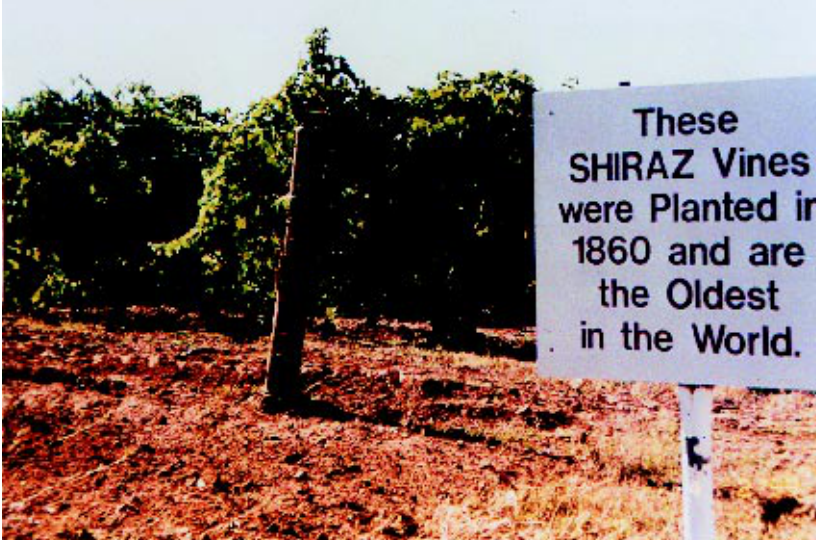
Fig. 2. 139-year-old ‘Shiraz’ vines at Chateau Tabilk, Tabilk, Victoria, Australia. Vines are healthy and still in full production. (Photo courtesy John Mac Cready, Sierra Vista winery, Placerville, CA,